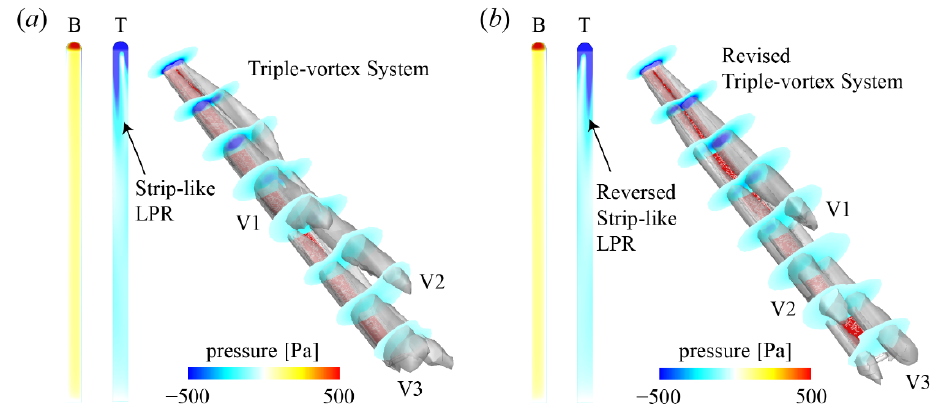
Figure 8. Effects of γ on the flow structure and pressure distribution of the ski: ( a ) α = 30°, β = 20°, and γ = 20° and ( b ) α = 30°, β = 20°, and γ = 40°. B: bottom view; T: top view; V: vortex. The ski is labeled by the red region.